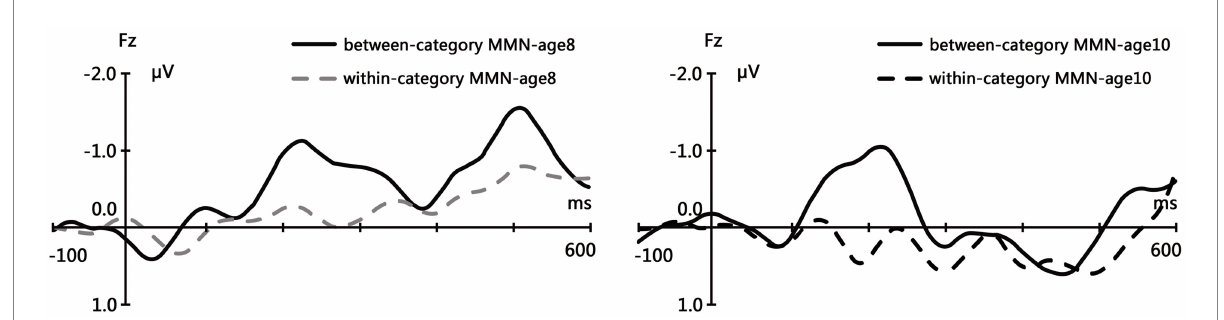
FIGURE 1 Grand average waveforms of Mismatch negativity (MMN) responses elicited by the between-category deviants ( p = 10%) and within-category deviants ( p = 10%) from the Fz electrode